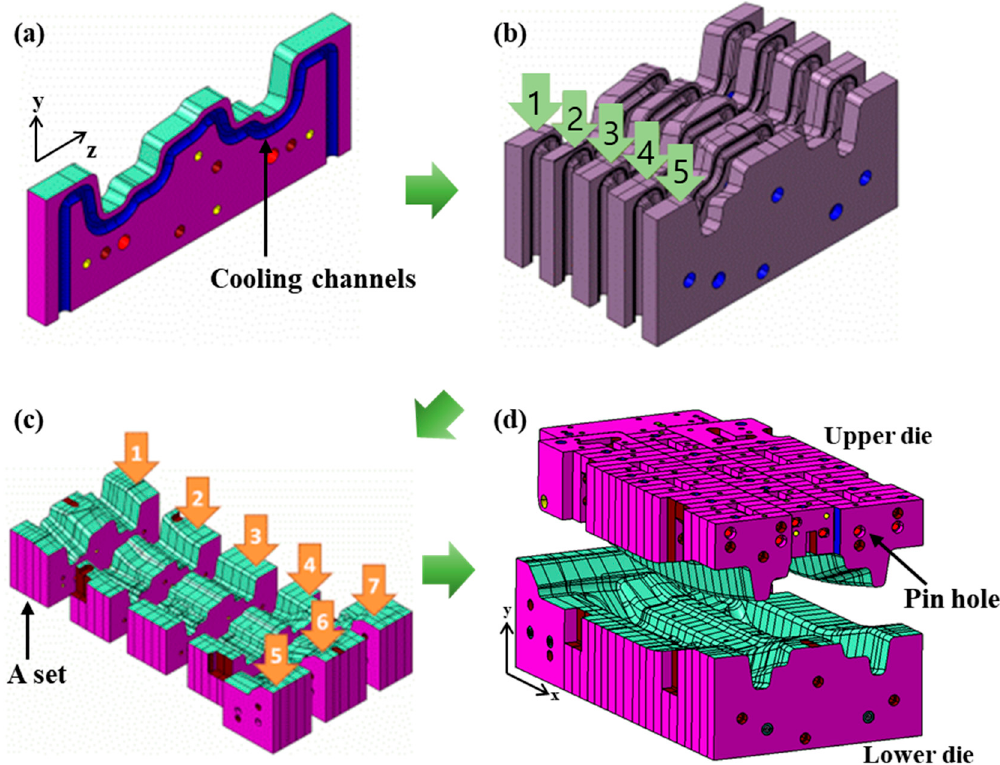
Figure 3. Slice die: ( a ) Each piece of the slice die; ( b ) Pieces for one set; ( c ) Sets for the lower slice die; ( d ) Upper and lower slice die.